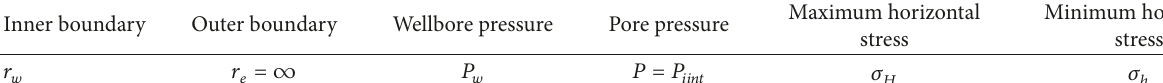
Table 3: General description of the problem.